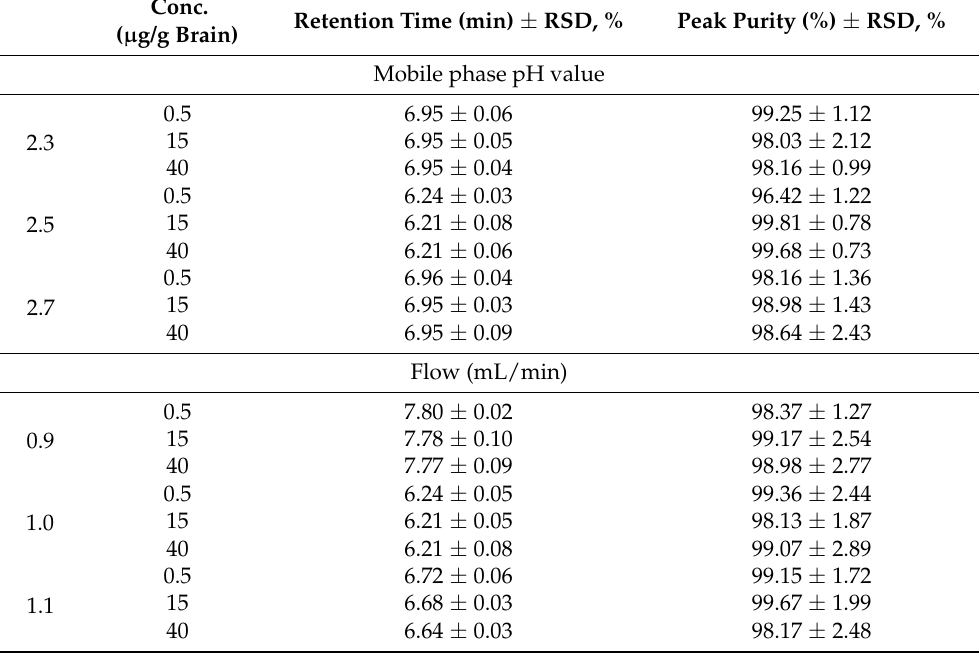
Table 5. Robustness of the method by variation of two chromatographic parameters (mobile phase ratio and mobile phase pH